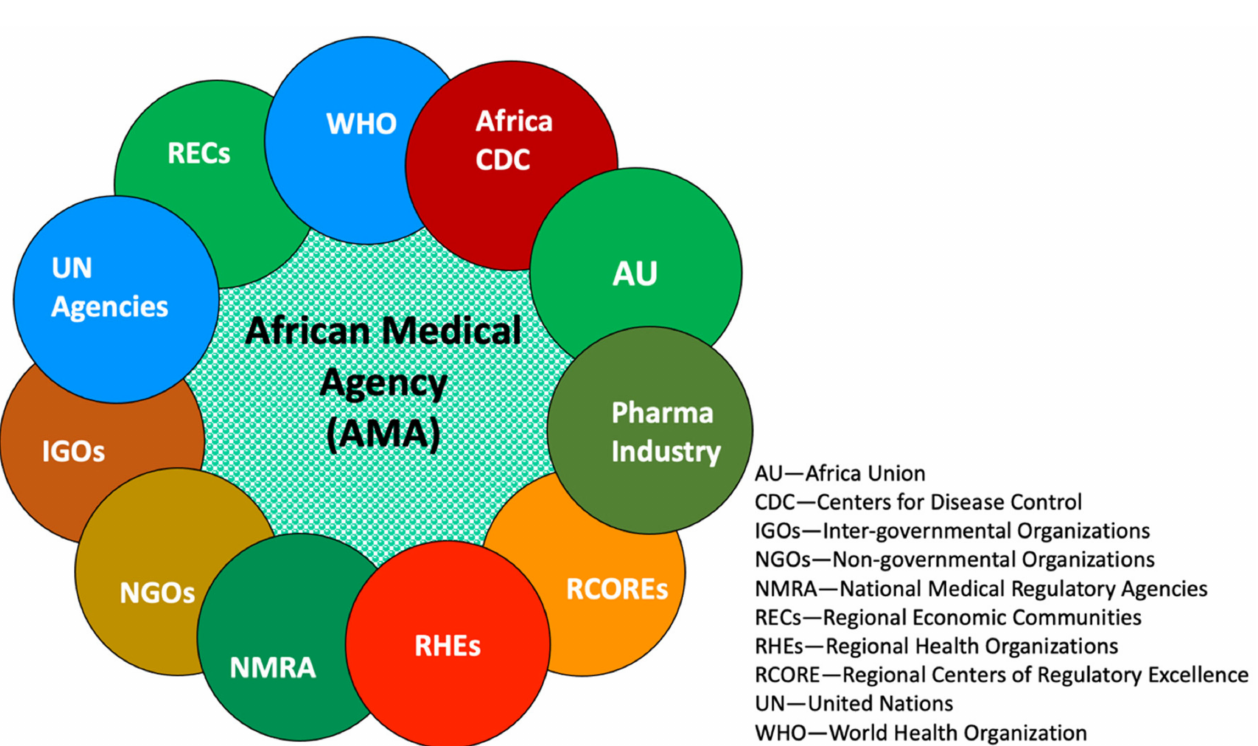
Figure 2. Evolution of African Medicines Agency. Source: AMRH, 2015.